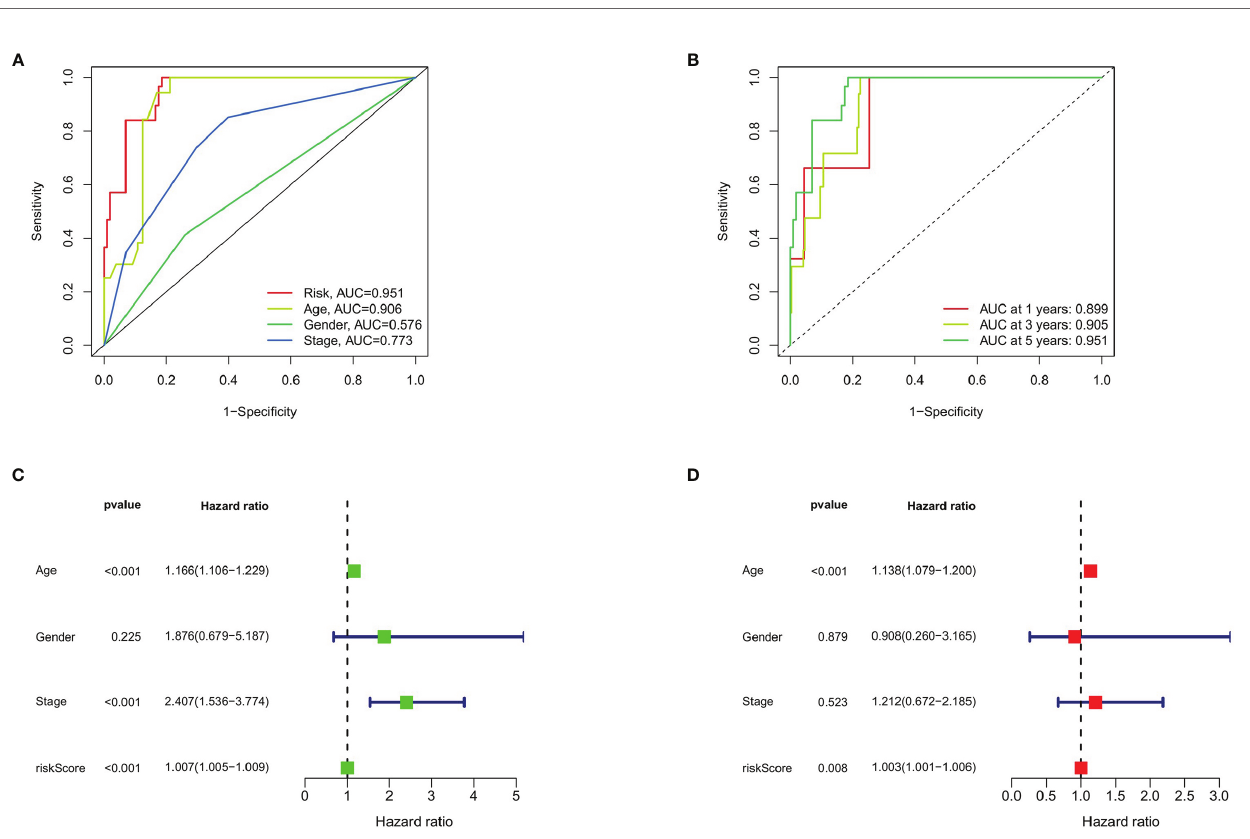
FIGURE 5 | Prognostic signature validation. (A) The ROC curves of risk score, age, gender, and stage in THCA. (B) The ROC curves of prognostic signature in THCA at 1, 3, and 5 years. (C) Forest plot of risk score and clinical data analyzed by univariate Cox regression. (D) Univariate Cox regression based on risk score and clinical data analyzed by univariate Cox